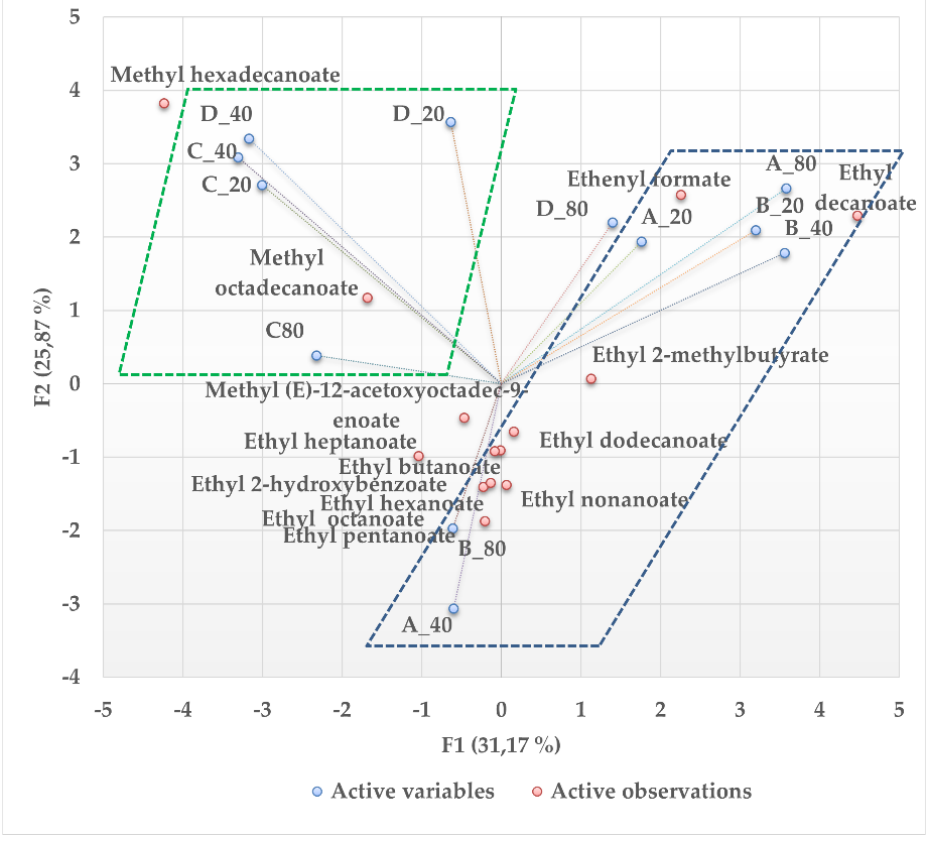
Figure 5. Principal component analysis (PCA) for mistletoe macerates obtained after 28 days of mistletoe maceration (20 g/L, 40 g/L, and 80 g/L; ethanol – water solution A: 25%, B: 40%, C: 55%, and D: 70% v/v ethanol) at room temperature and in darkness, based on the esters represented in each macerate. Samples with lower ethanol content and characteristic esters are circled in blue, samples with higher ethanol content and characteristic esters are circled in green.